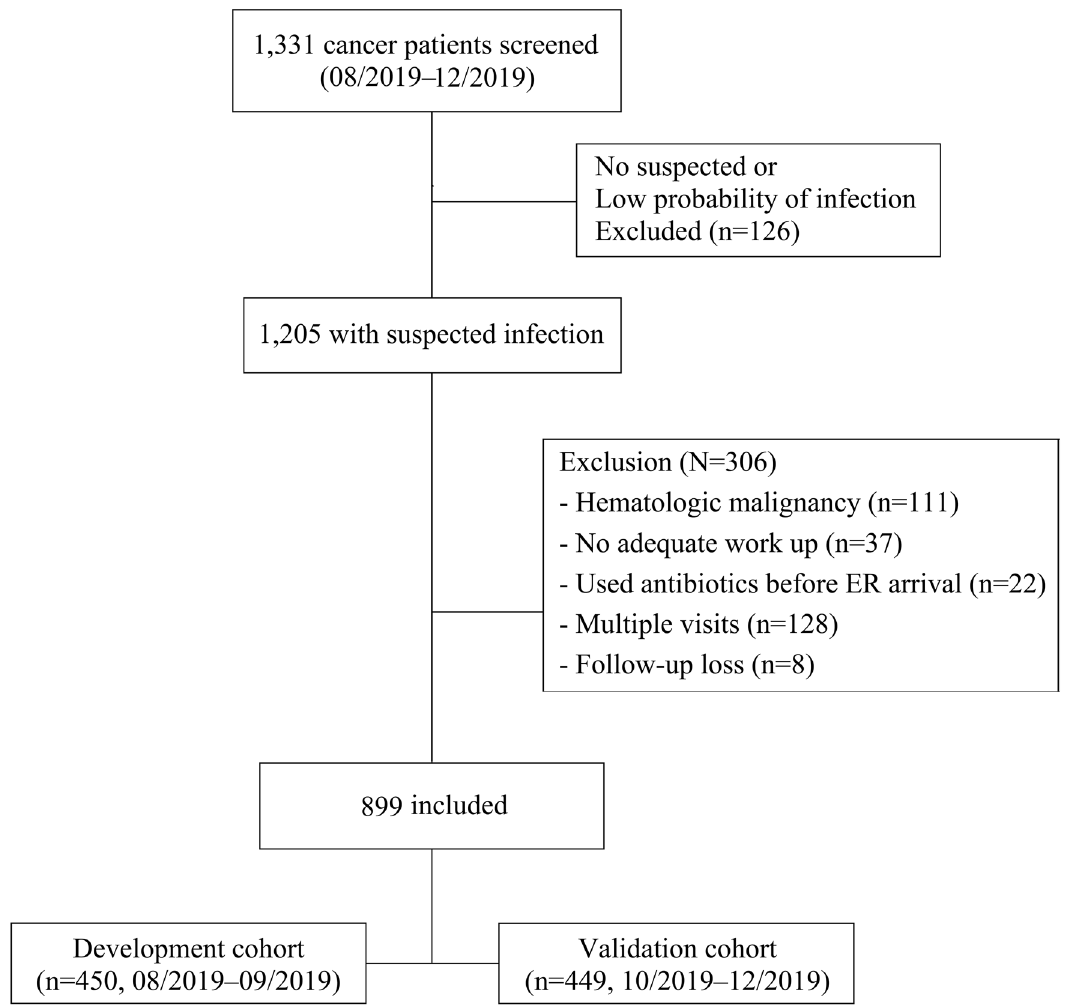
Figure 1. Flow chart. A total of 1331 patients with cancer were screened during the study period. First, patients with no suspected infection or low probability of infection (n = 126) were excluded. Among the remaining 1205 patients, 306 were excluded for the following reasons: 111 with hematologic malignancies, 37 with no adequate workup, 22 with used antibiotics before ER arrival, 128 with multiple visits, and 8 lost at follow-up. A total of 899 patients were included: 450 in the development cohort or 449 in the validation cohort. (Image created using Adobe Photoshop Version, 22.1.0 20201125.r.94 2020/11/25: 4b16c876033 ×